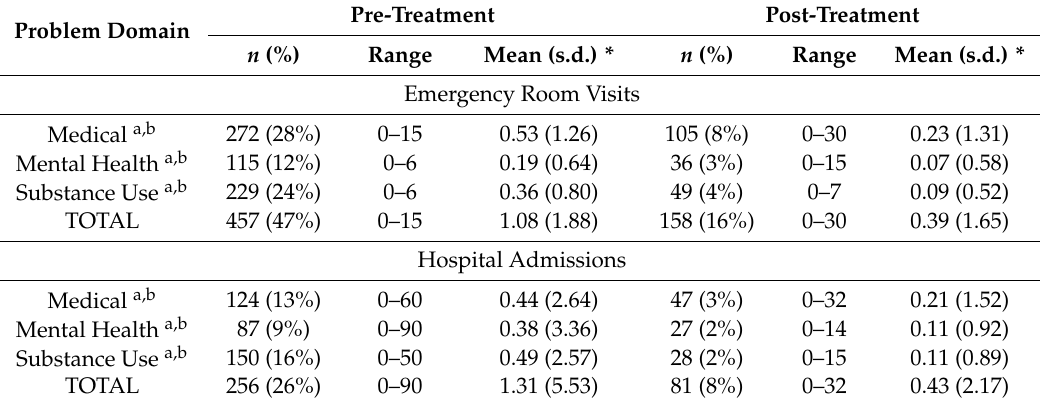
Table 1. Number of participants with emergency room visits and inpatient admissions for physical, mental health, and substance use problems before and after treatment and mean number of ER visits/ and inpatient days ( n =